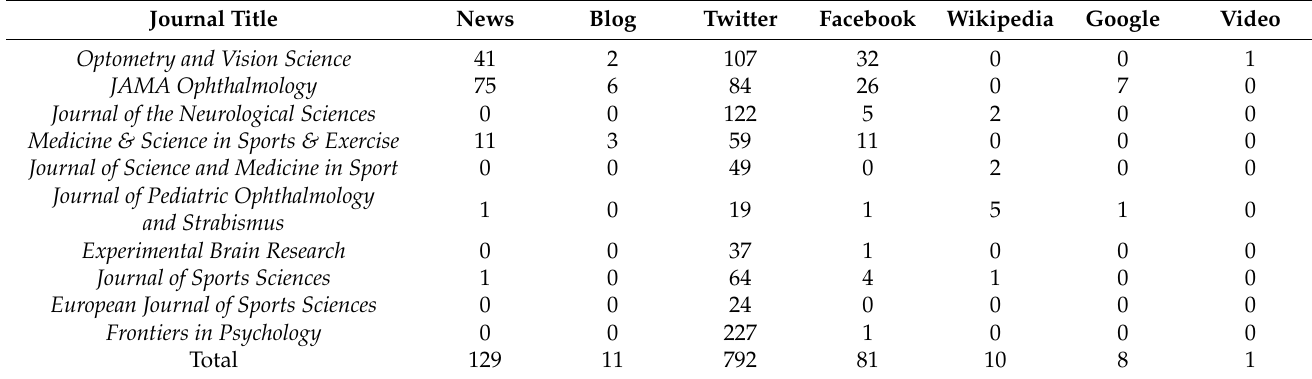
Table 2. Mention of the journals on the different social media